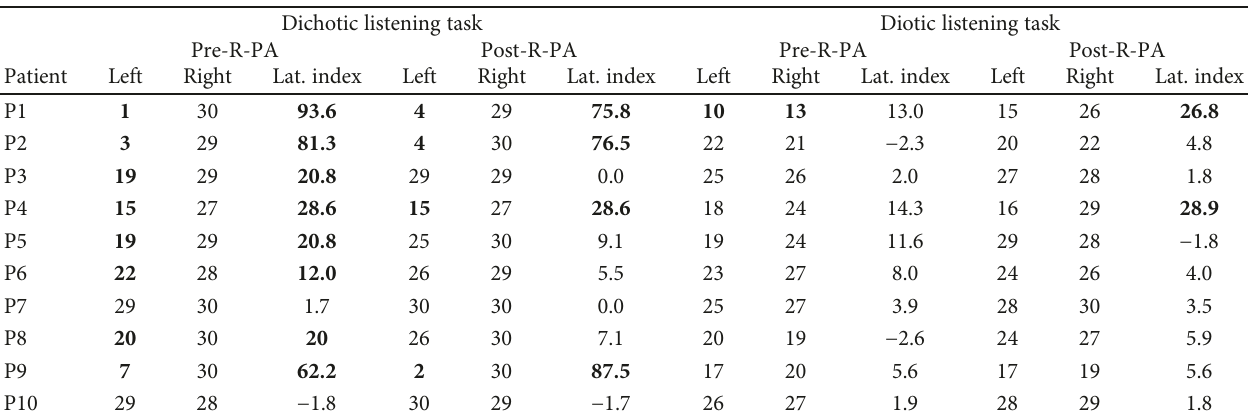
Table 2: Performance in dichotic and diotic listening tasks before (pre-R-PA) and after (post-R-PA) exposure to R-PA, listing the number of words reported for the left and right ears as well as the lateralization index. Scores outside the normal range are highlighted in